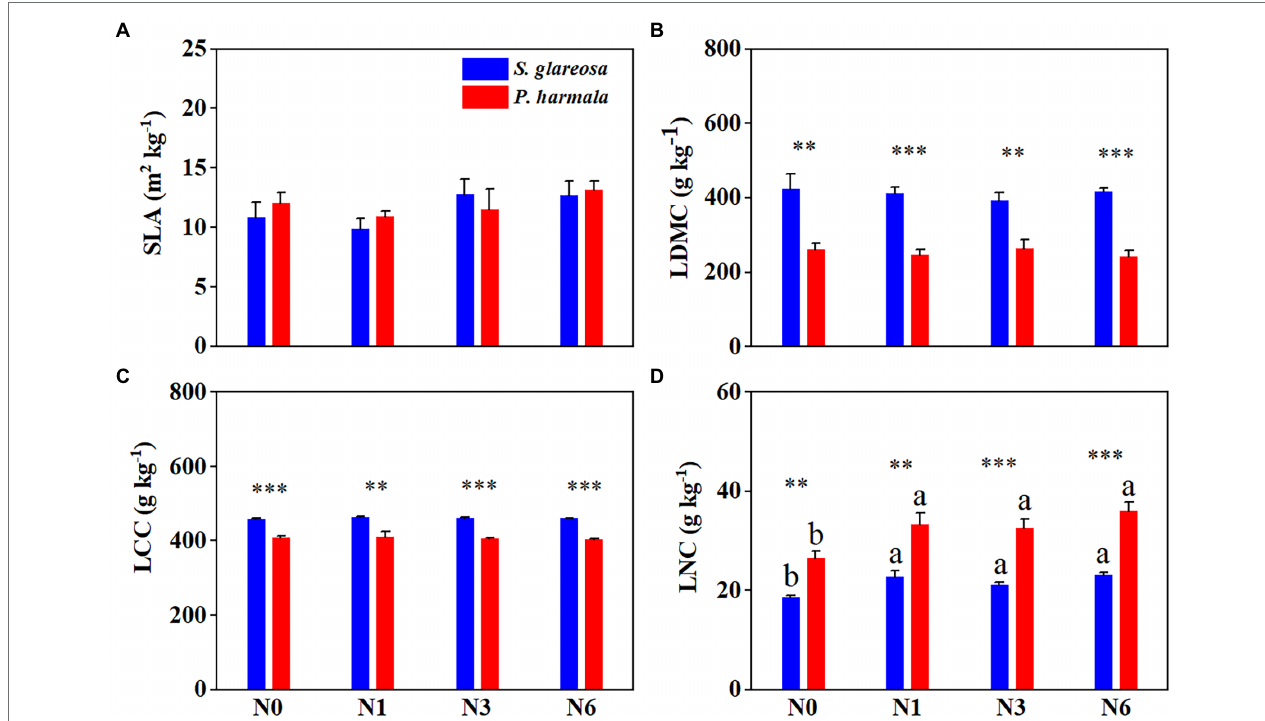
FIGURE 1 | Response of leaf morphological traits in Stipa glareosa and Peganum harmala to the different N treatments. (A) Specific leaf area (SLA), (B) leaf dry matter content (LDMC), (C) leaf carbon content (LCC), and (D) leaf nitrogen content (LNC). Values are presented as the means ± SEs ( n = 5). Different lower-case letters represent significant differences among the treatments for each species ( p < 0.05). Asterisks represents significant differences between S. glareosa and P. harmala (** p < 0.01, and *** p <